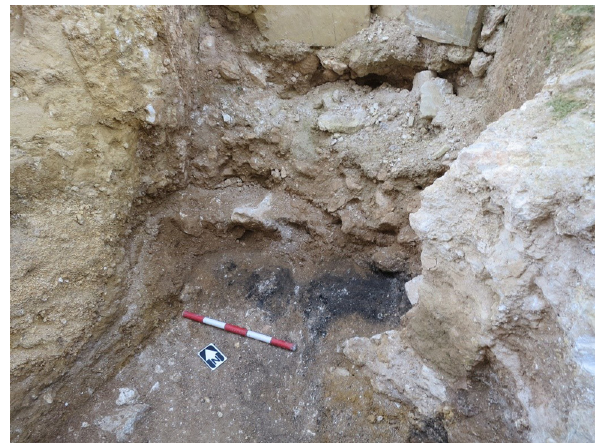
Figure 17: Location of the ashy traces within the